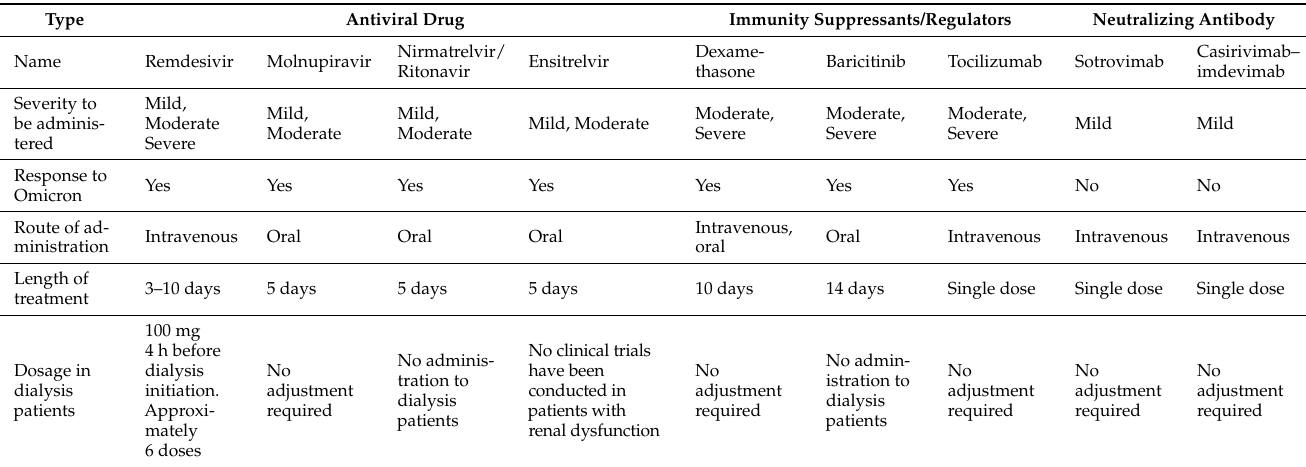
Table 1. Current COVID-19 treatment for patients undergoing